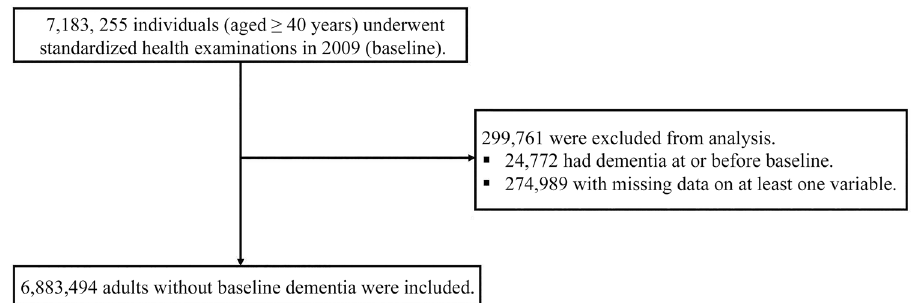
Figure 1. Flowchart outlining selection of the study